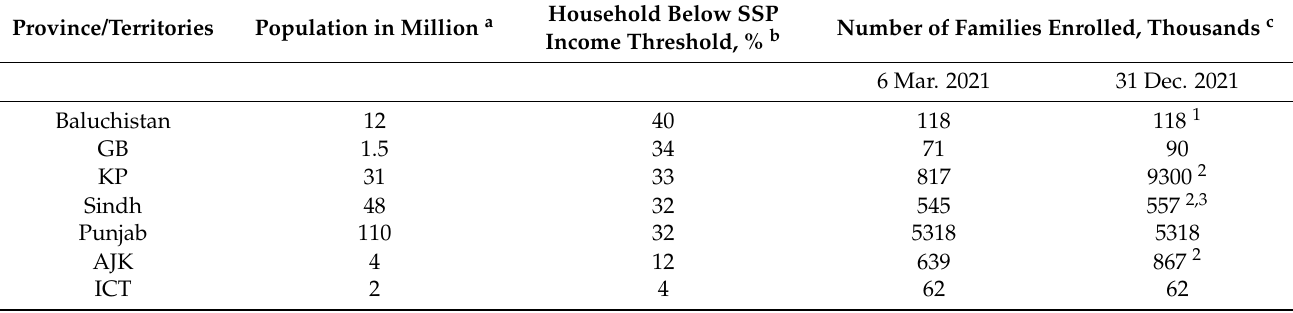
Table 1. Pakistan provincial/territorial demographics and SSP enrollment